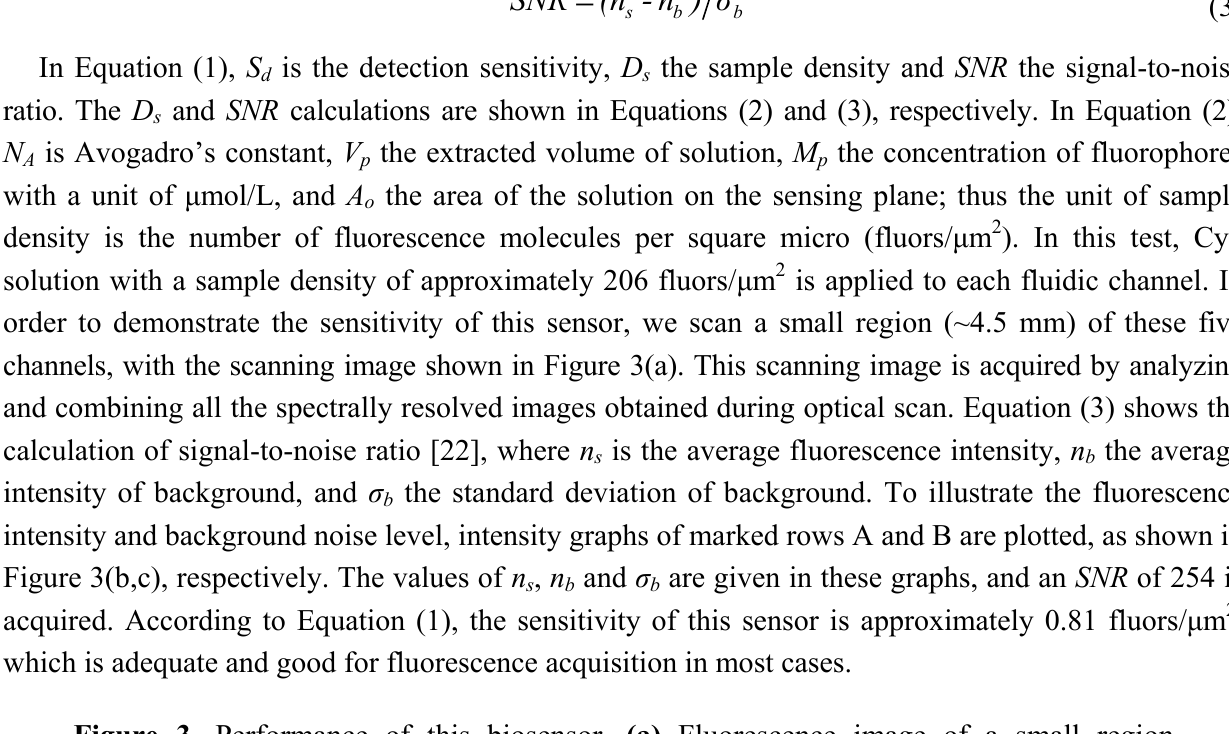
Figure 3. Performance of this biosensor. (a) Fluorescence image of a small region (~4.5 mm) of the fluidic system. (b) Intensity curve of marked row A. (c) Intensity curve of marked row B. (d) Gray sum of all pixels at horizontal